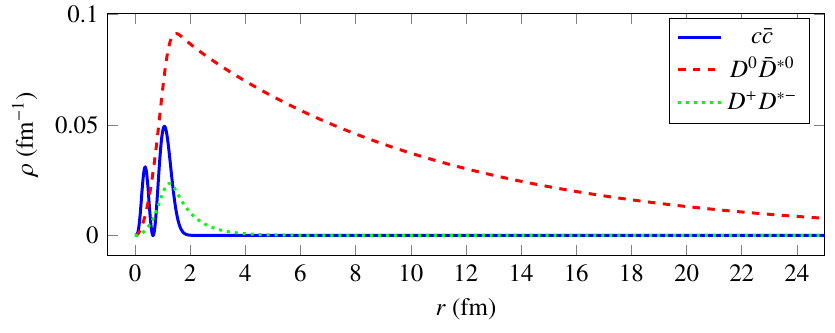
Figure 3. Radial probability densities for the diabatic X (3872). The long tail of the molecular D 0 ¯ D ∗ 0 component reaches up to r ≈ 70